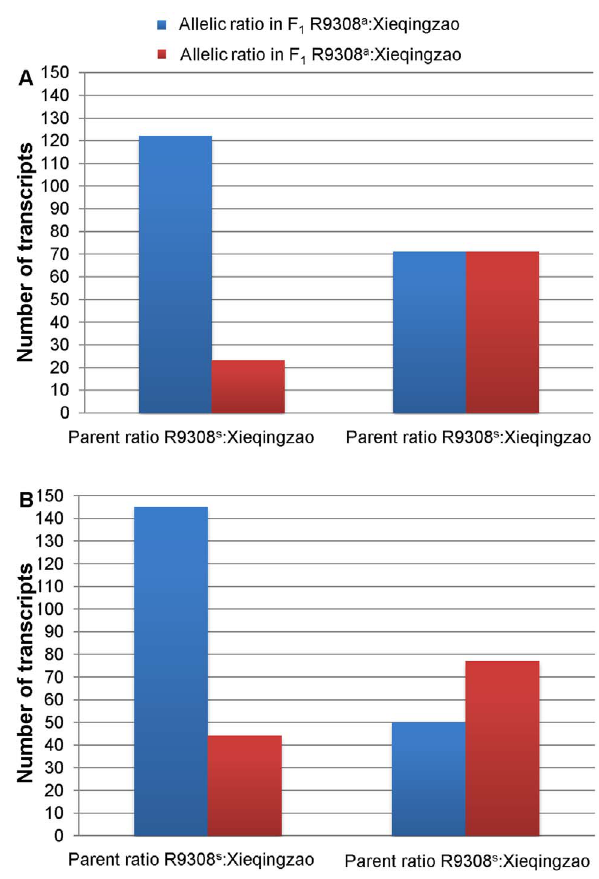
Figure 5. Allelic biases in Xieyou9308 according to their differences between parents. R9308 s , gene expression levels in R9308; Xieqingzao B s , gene expression levels in Xieqingzao B; R9308 a , R9308 allele; Xieqingzao B a , Xieqingzao B allele.